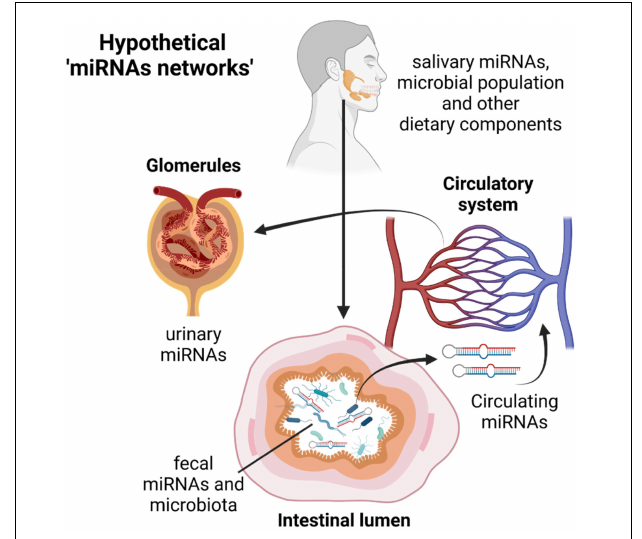
FIGURE 2 | The miRNAs journey through the human body: from the mouth to the intestine through the digestive tract, migration from the gut to the circulatory systems and excretion by urine. The possible miRNA-host-pathogen cross talks and network of interactions during this journey could better classify the patient’s molecular characteristics (and the healthy/disease status) and drive clinicians to identify personalized therapeutic treatments. This picture was created with